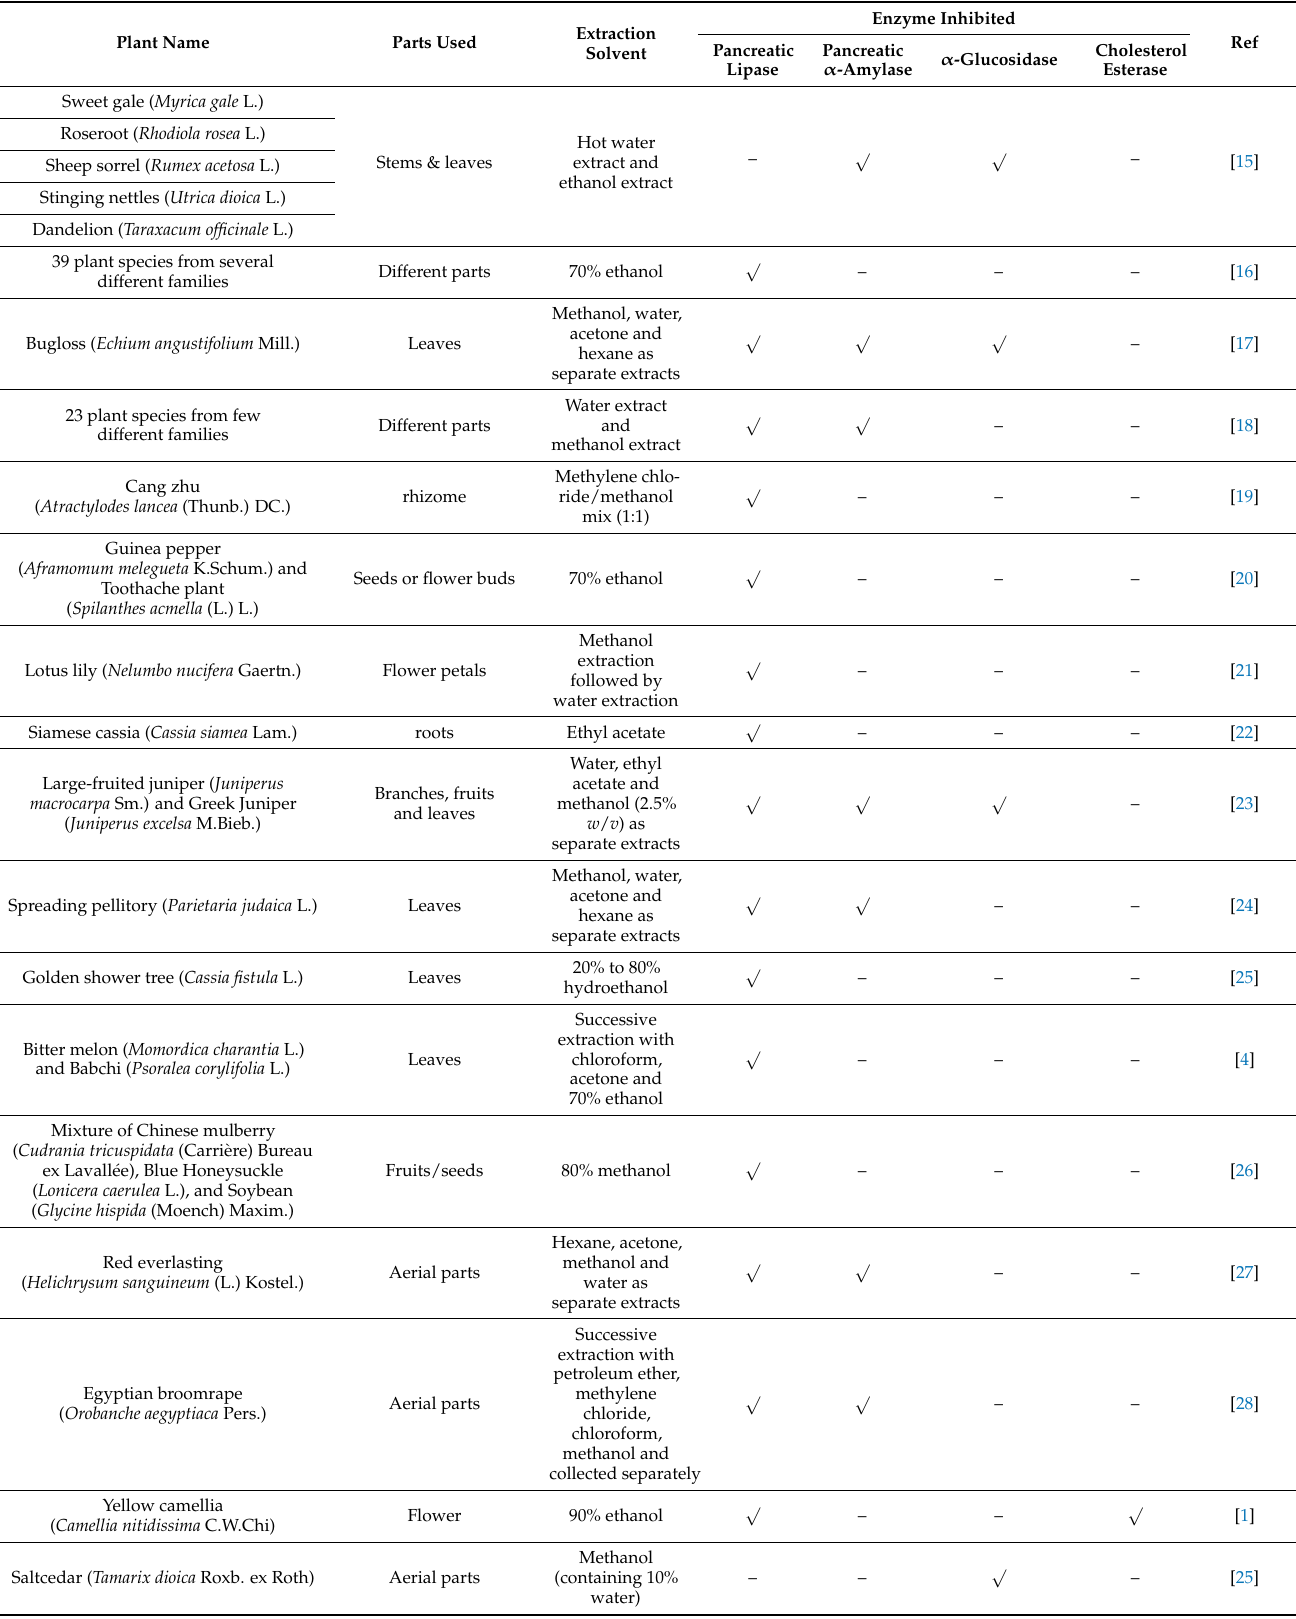
Table 1. Medicinal plants, plant parts, and the extraction solvents used for the screening of inhibitors of different metabolic